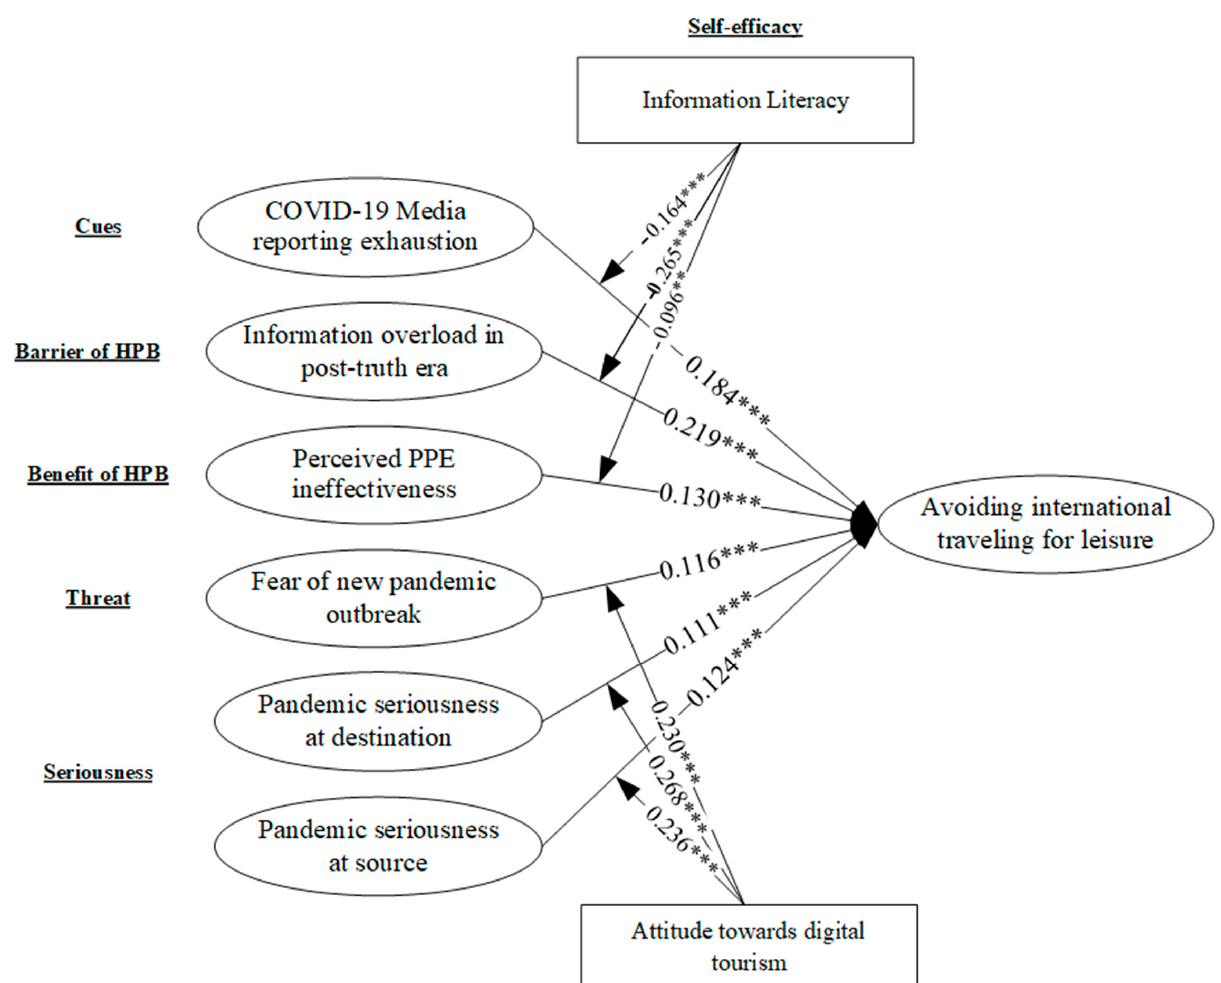
Figure-2. Graphical view of the structural model (proposed hypotheses). Figure 2. Graphical view of the structural model (proposed hypotheses). *** p < 0.001. ** p < *** p < 0.001. ** p < 0.010. * p < 0.050.